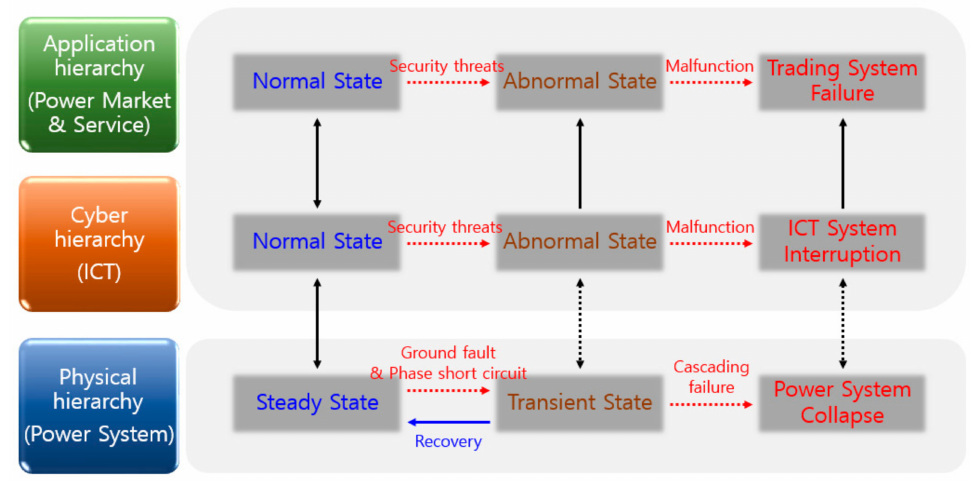
Figure 1. Correlation by SG